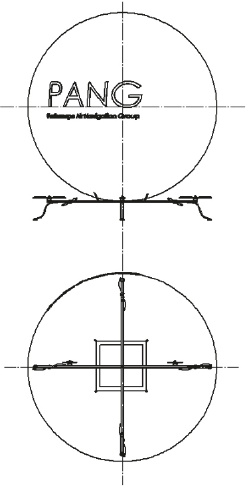
Figure 3: HUAS 3D CAD.